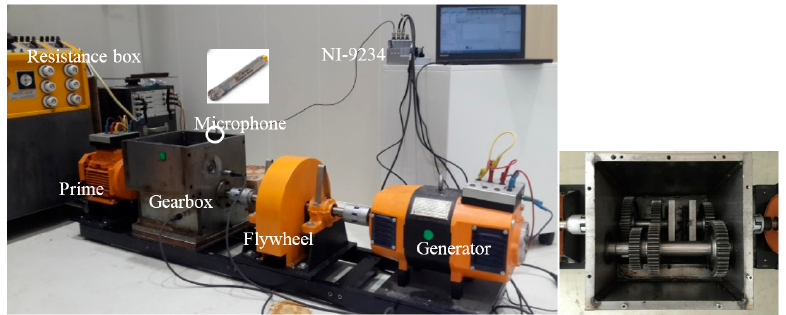
Figure 4. Established fault diagnosis test rig.